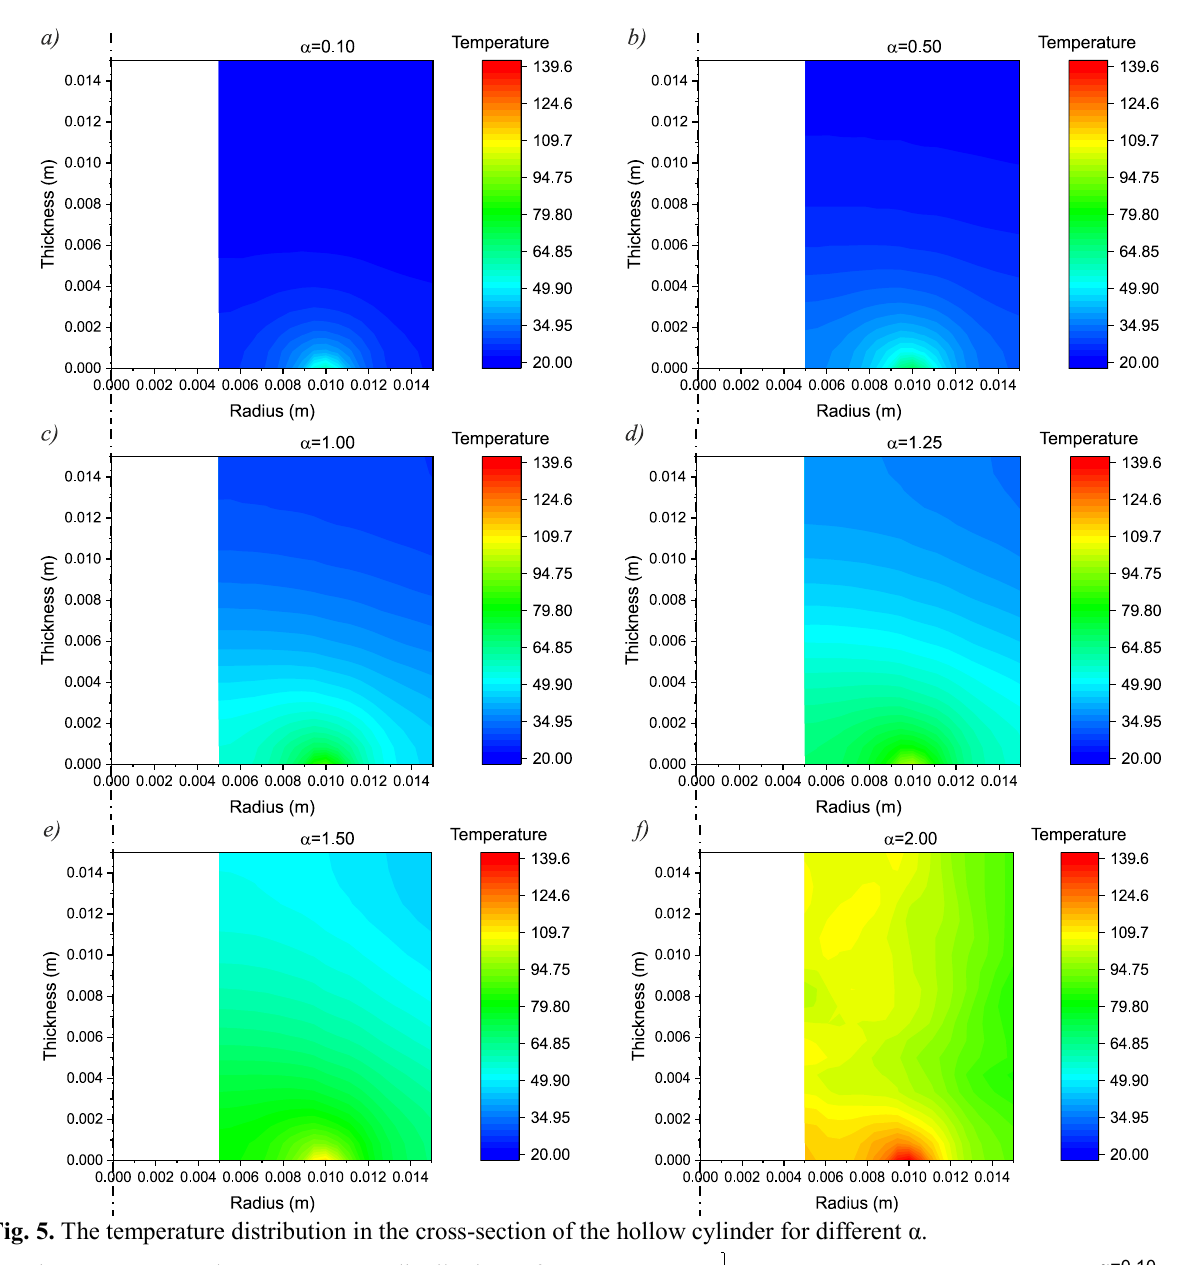
Fig. 5. The temperature distribution in the cross-section of the hollow cylinder for different α. Fig. 5 presents the temperature distributions for